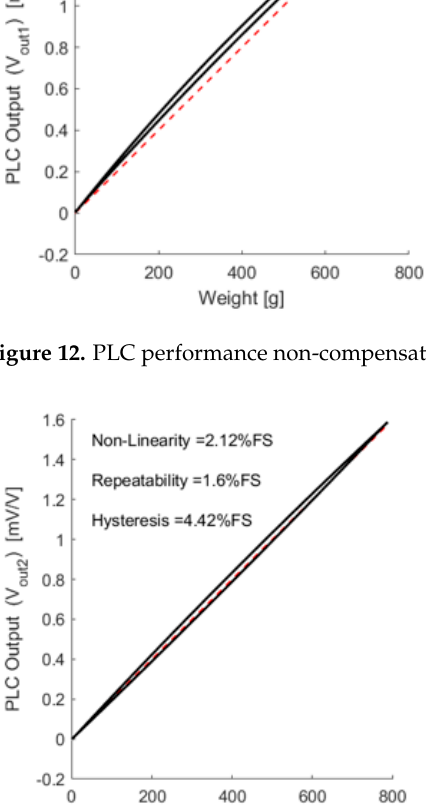
Figure 13. The calibrated PLC performance characterization.